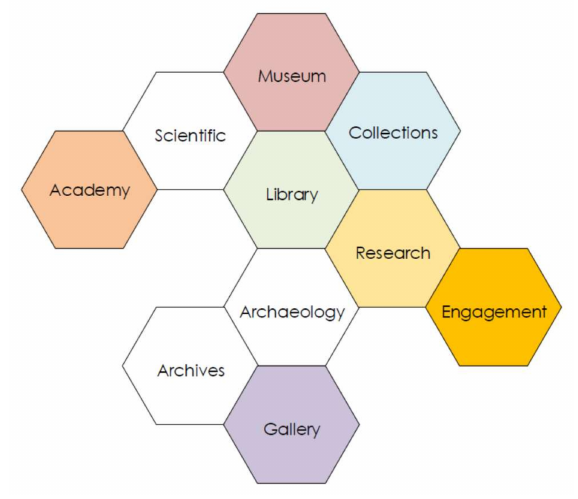
Figure 3. CIDOC-CRM is the semantic glue for cultural heritage datasets